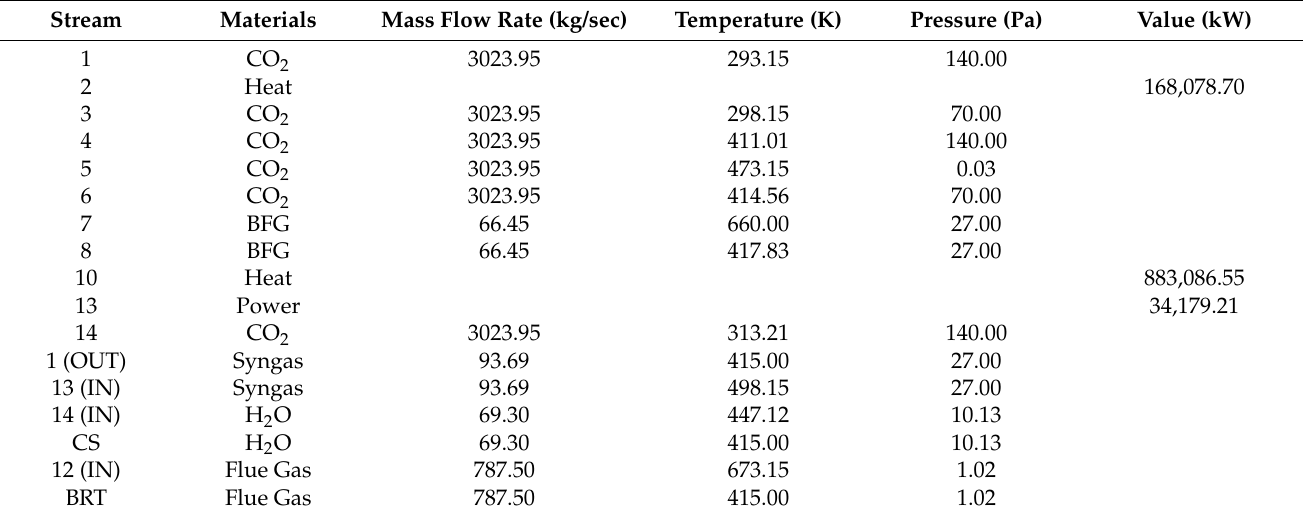
Table 10. Stream parameters in RANKI.